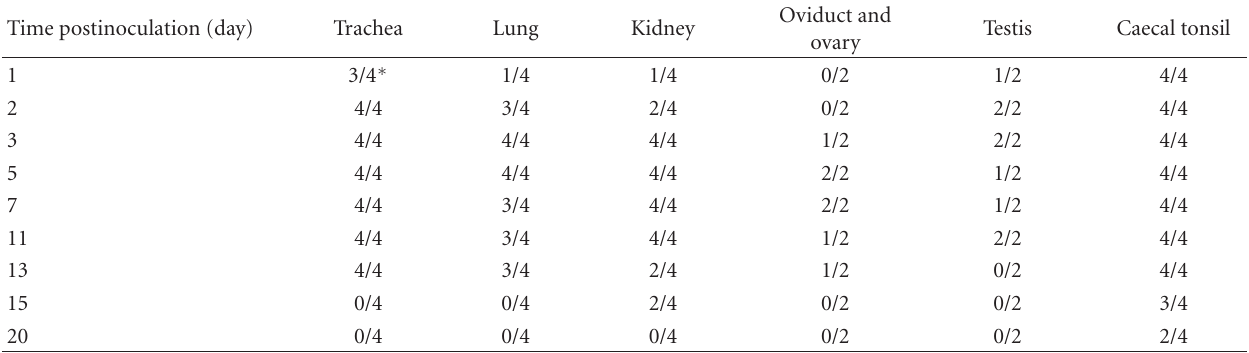
Table 2: Virus detection from various organs of chickens postinoculated (PI) of infectious bronchitis virus isolate IRFIBV32. Time postinoculation (day) Trachea